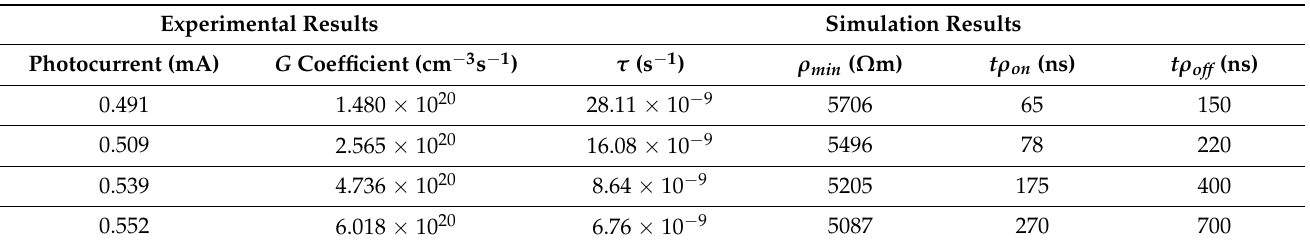
Table 3. The experimental and assigned simulation results for sample GaP-1. Experimental